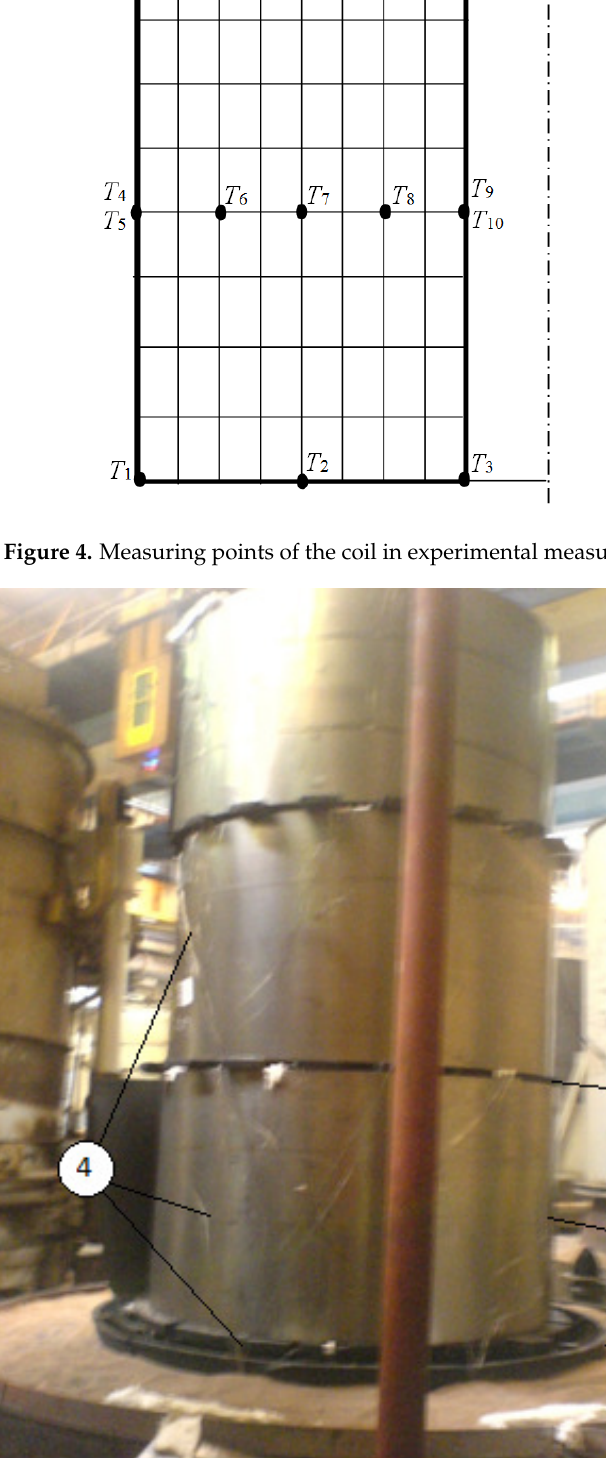
Figure 5. The placement of coils on the stand (1—stand, 2—coil, 3—convective insert,